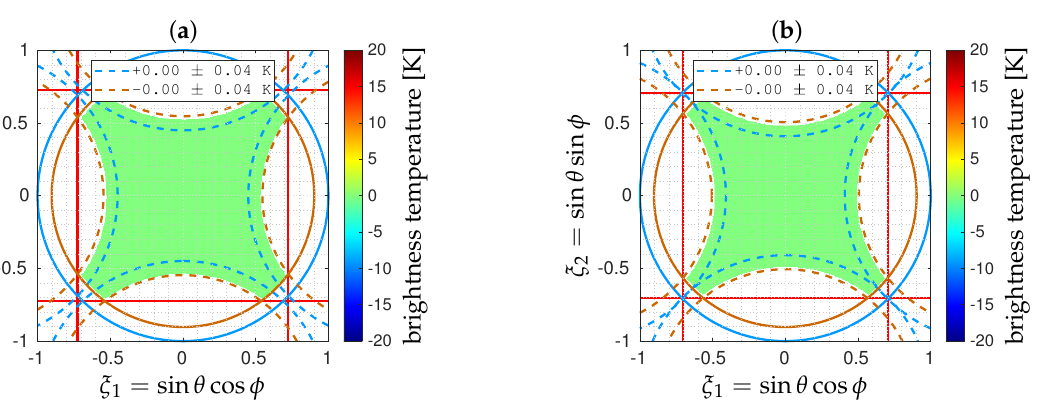
Figure 8. Error maps (cid:101) T − T obtained in X polarization with the cross-shaped array shown in Figure 4 for two values of the shortest spacing: ( a ) d = 0.69 λ and ( b ) d = 0.71 λ (similar results are obtained in Y polarization). In both cases, complex visibilities V are free from any additional random noise ∆ V . Referring back to Figure 2, Earth aliases are shown with dashed maroon lines. Bias and standard deviation are given in Earth alias-free FOV (dashed maroon line) and in the sky alias-free FOV (dashed blue